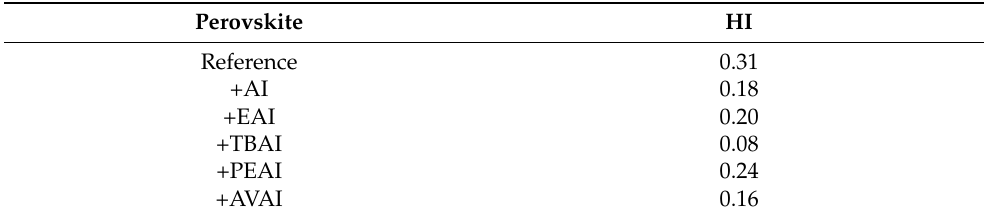
Table 2. Summary table of the Hysteresis Index (HI) that has been calculated for each one of the C-PSCs under study.